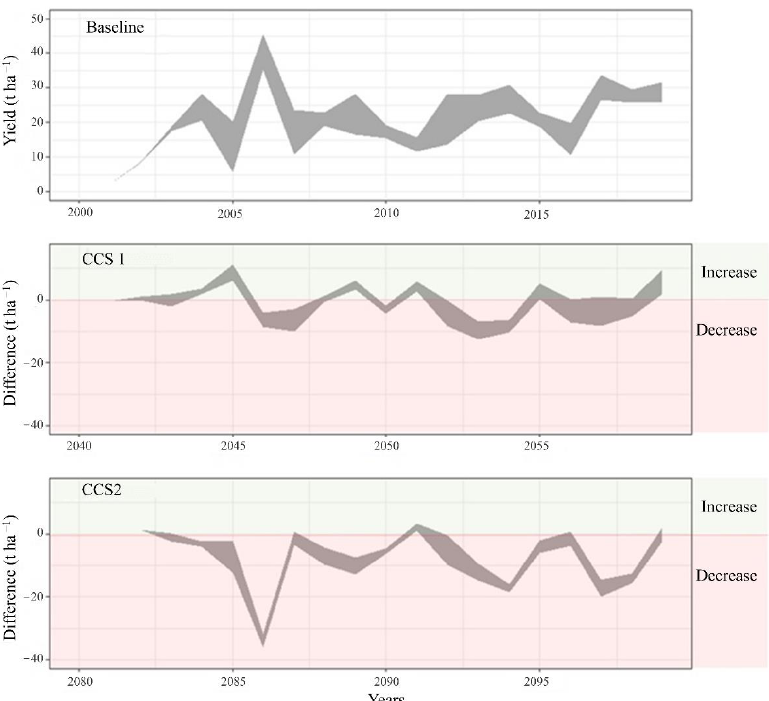
Figure 11. Effect of climate change on oil palm yields. For each scenario, the range of the yield performance of the eight selected APBs is presented (gray graph). When the yield (tons per hectare) in the CCS is lower than the baseline, there is a decrease (red box), otherwise there is an increase in yield (green box).